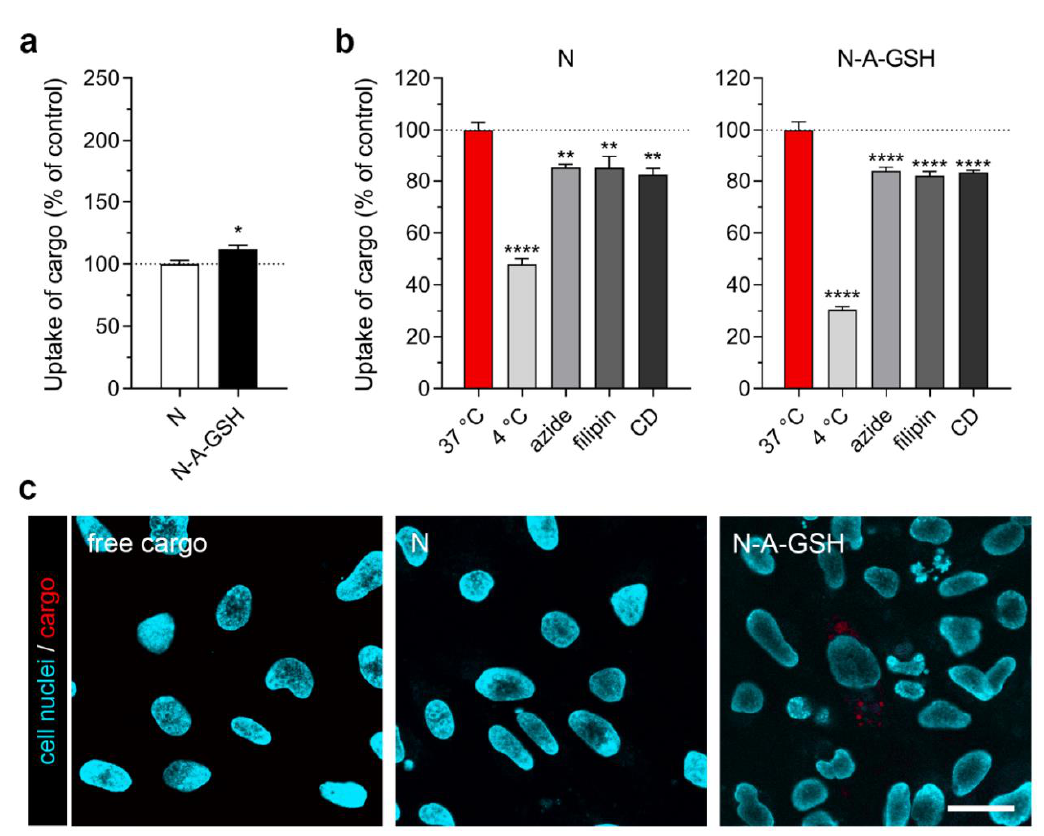
Figure 6. Cellular uptake of niosome cargo in hCMEC / D3 brain endothelial cells after 4 h of incubation. ( a ) Uptake of cargo loaded in non-targeted (N) and alanine-glutathione targeted (N-A-GSH) niosomes. Values presented are means ± SEM. Statistical analysis: unpaired t test; * p < 0.05; n = 6. ( b ) E ff ect of temperature and treatment with sodium-azide (1 mg / mL), filipin (5 µ g / mL) or cytochalasin D (CD; 0.125 µ g / mL) on the cellular uptake of cargo. Values presented are means ± SEM. Statistical analysis: one-way ANOVA followed by Dunnett’s posttest; ** p < 0.01, **** p < 0.0001 compared to the first column of each niosome group; n = 6. ( c ) Live cell visualization of cargo taken up by hCMEC / D3 cells. Free cargo: cargo not loaded in niosomes. Bar: 25 µm.